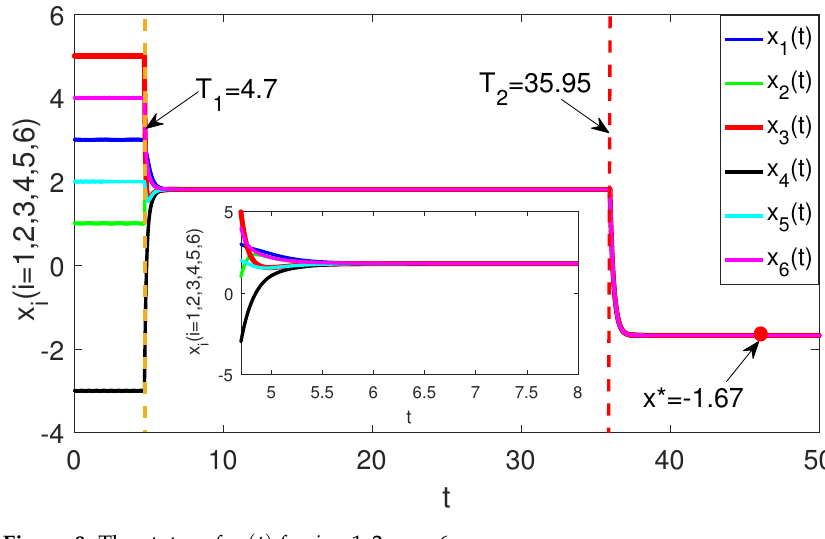
Figure 9. The states of x i ( t ) for i = 1,2, · · ·